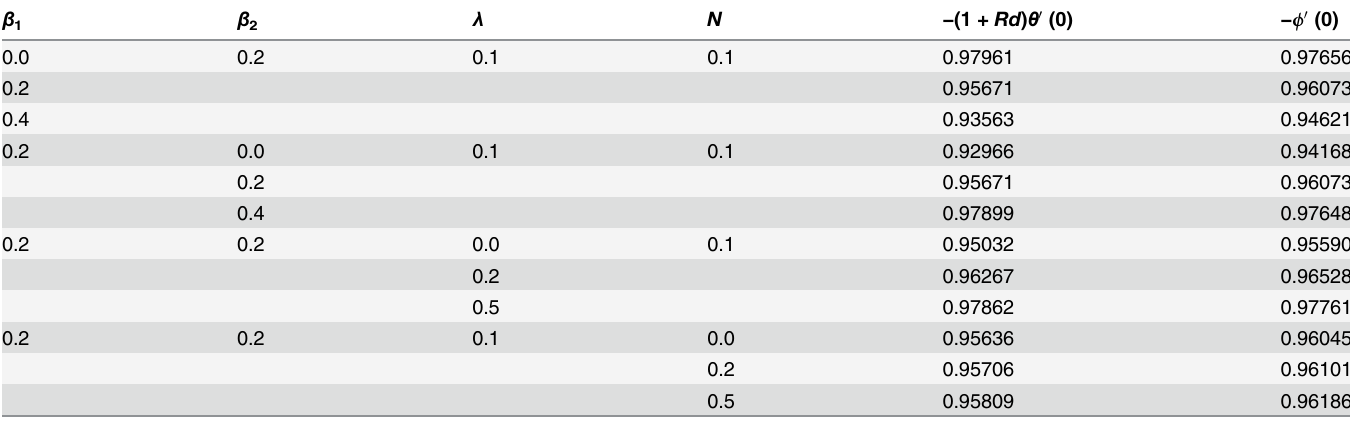
Table 2. Values of local Nusselt number (Re x ) − 1/2 Nu x and local Sherwood number (Re x ) − 1/2 Sh x for different values of β 1 , β 2 , λ and N when Pr = 1.0 = Sc , Rd = 0.2 = γ and ε